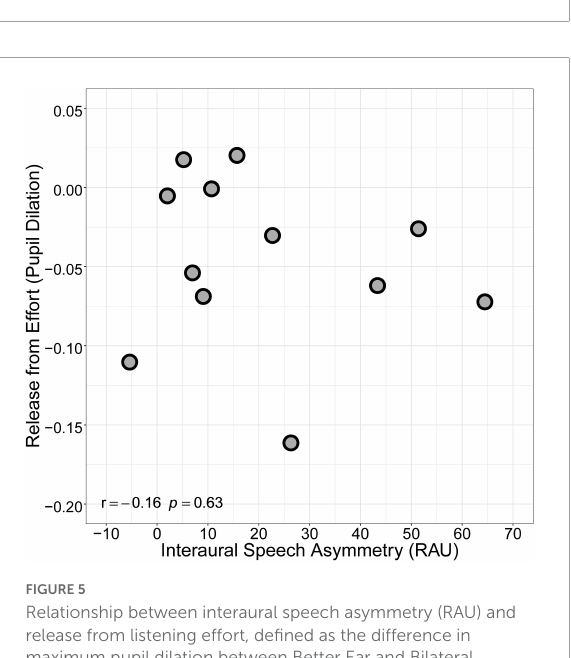
FIGURE5 Relationship between interaural speech asymmetry (RAU) and release from listening effort, defined as the difference in maximum pupil dilation between Better Ear and Bilateral